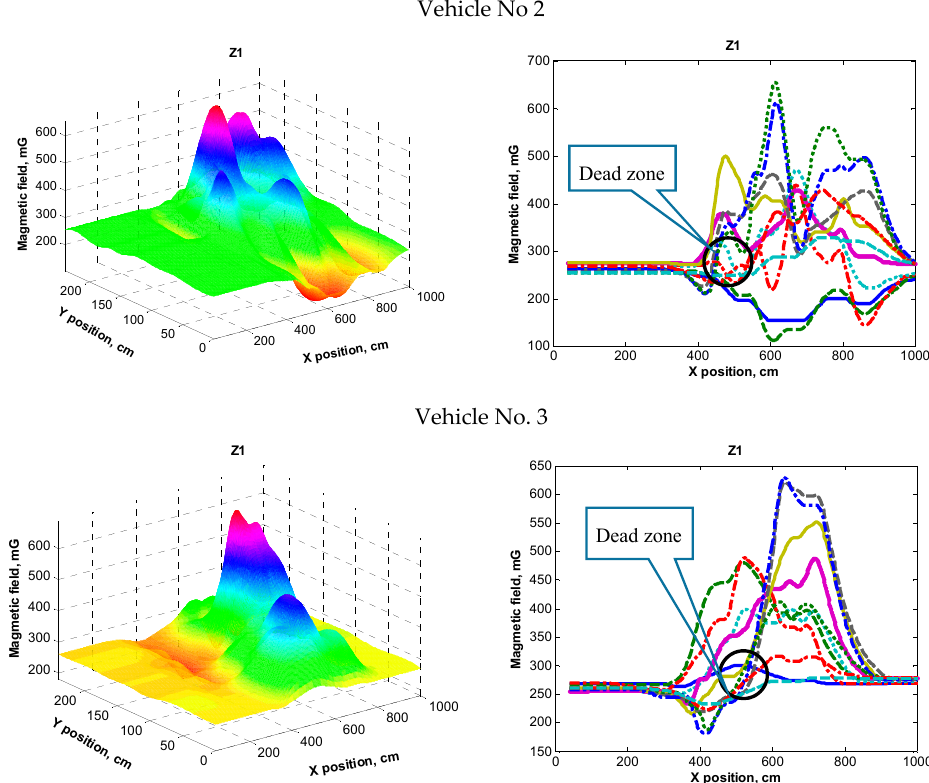
Figure 4. The distribution of the magnetic field distortion (Z component) caused by three different vehicles (different color means different position of sensor with respect to the Y axis—across the vehicle).